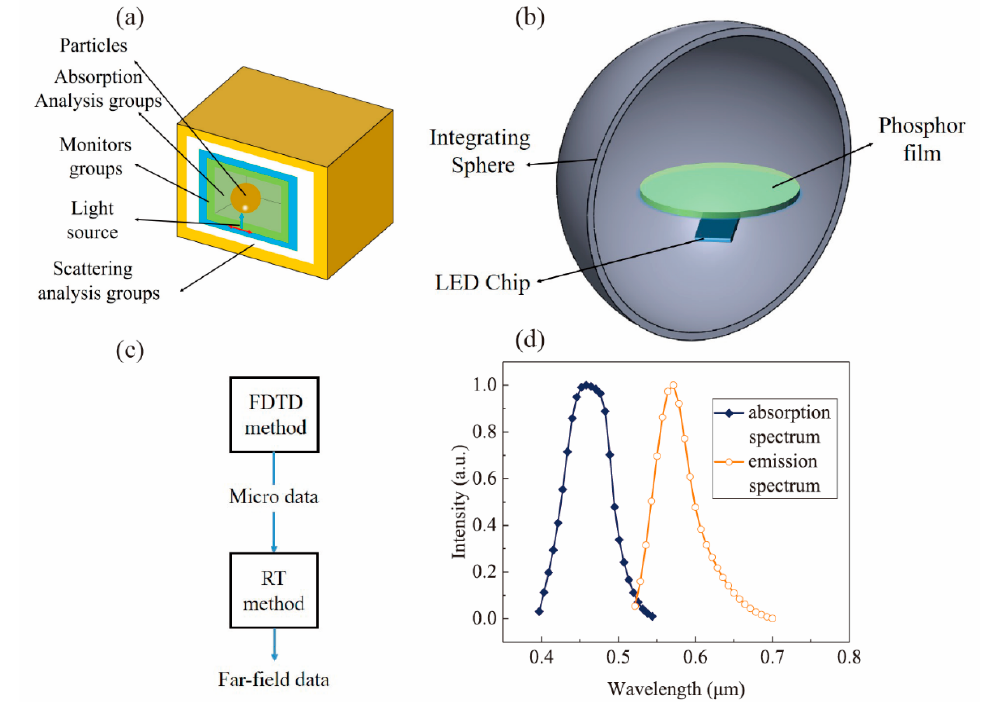
Figure 1. ( a ) Schematic of the finite-difference time-domain (FDTD) method simulation model. ( b ) Schematic of the ray-tracing (RT) method simulation method. ( c ) Schematic of the data transfer from the FDTD method to the RT method. ( d ) The absorption and emission spectra for the phosphor in the simulation.